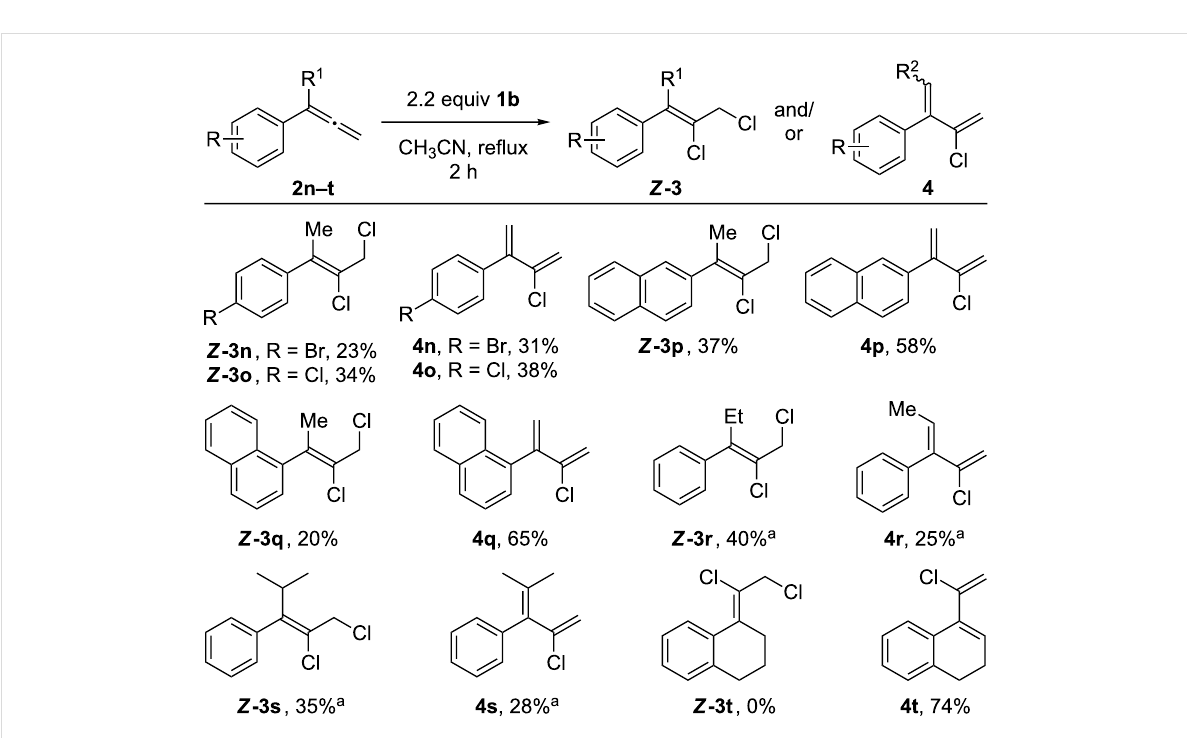
Scheme 4: Chlorination of various α -substituted phenylallene derivatives. General conditions: Allene 2a (0.2 mmol, 1 equiv) was added dropwise over 1 h to a solution of 1b (0.44 mmol, 2.2 equiv) in 0.1 M CH 3 CN under reflux conditions, and the reaction stirred for 1 h; isolated yields. a 1 H NMR yield using HMDSO as internal